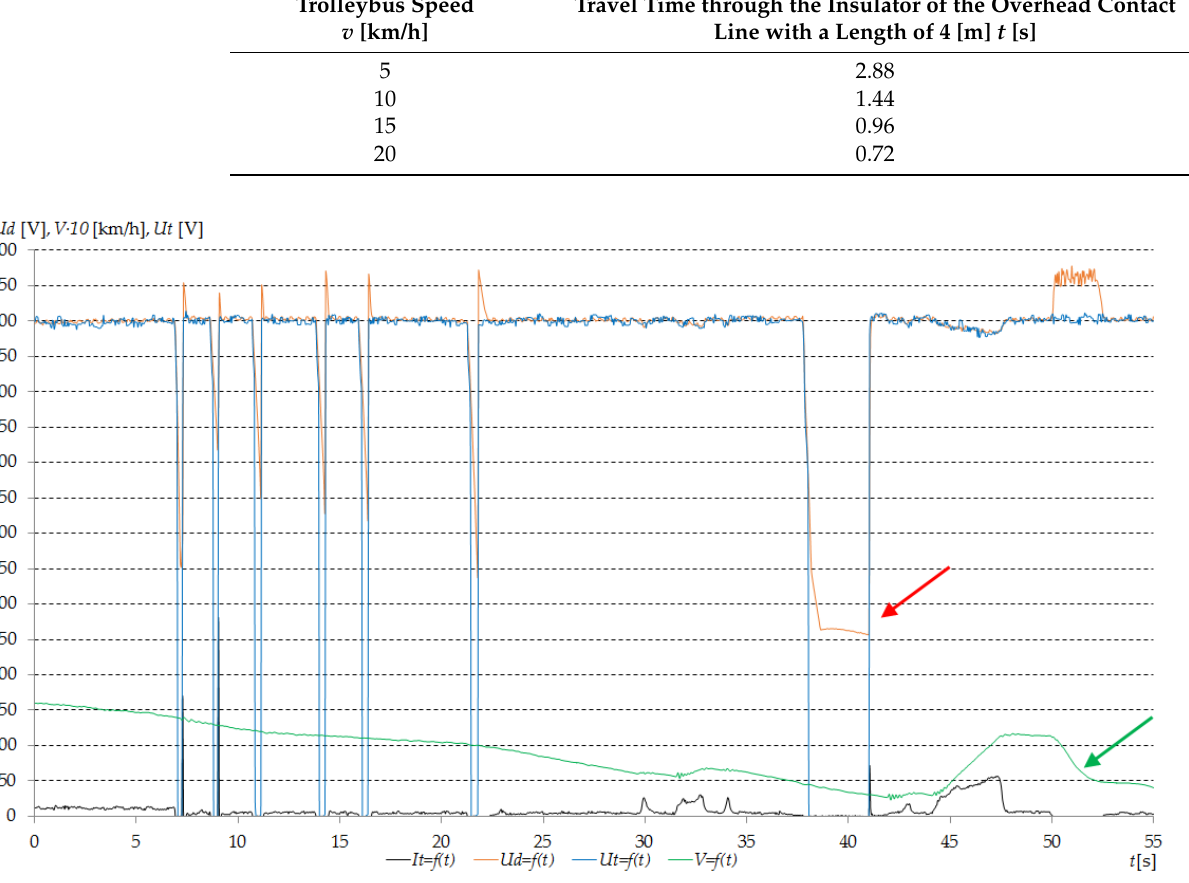
Figure 2. Curves of time vs. traction network current I [A] (black line), traction network voltage Ut [V] (blue line), trolley- bus speed (scale x 0.1) v [km/h] (green line), and traction inverter DC link voltage Ud [V] for a trolleybus passing through a series of section insulators [21].